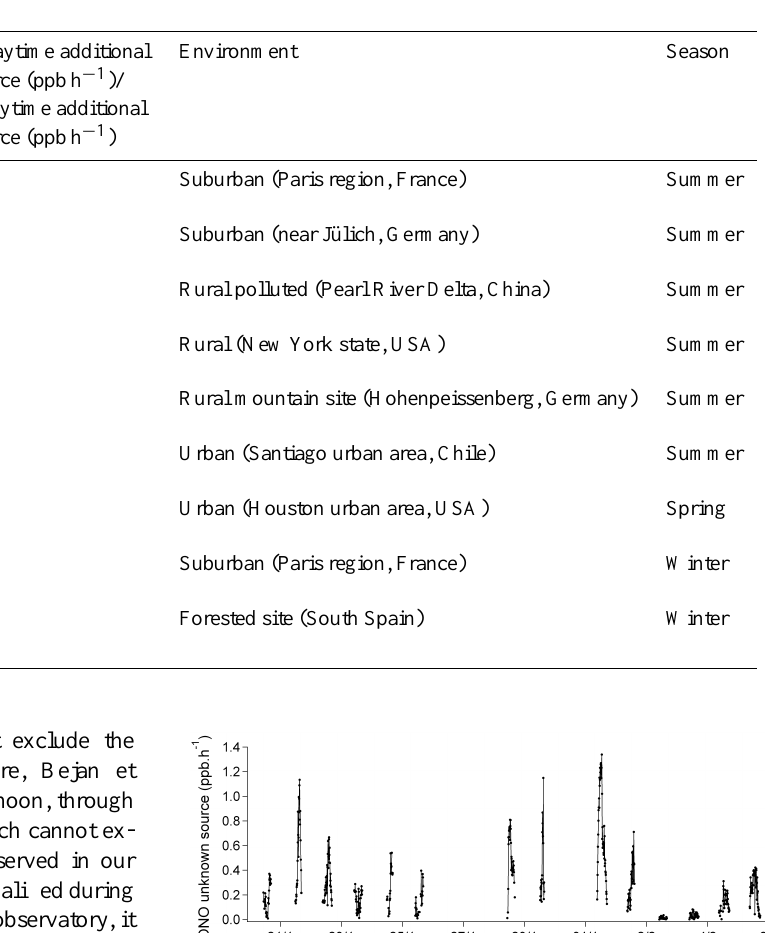
Table 2. Comparison of the level of the unknown HONO Source from various field campaigns conducted in various environments and different seasons.